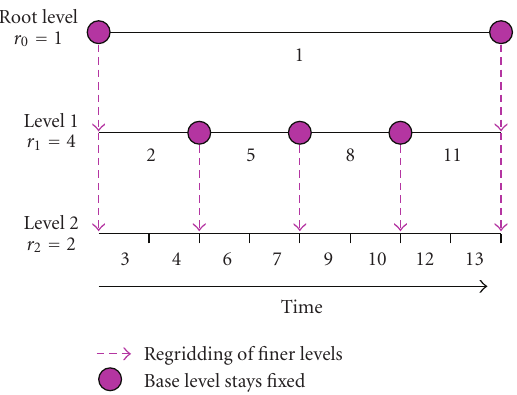
Figure 8: Structured AMR allows for recursively refined temporal integration.